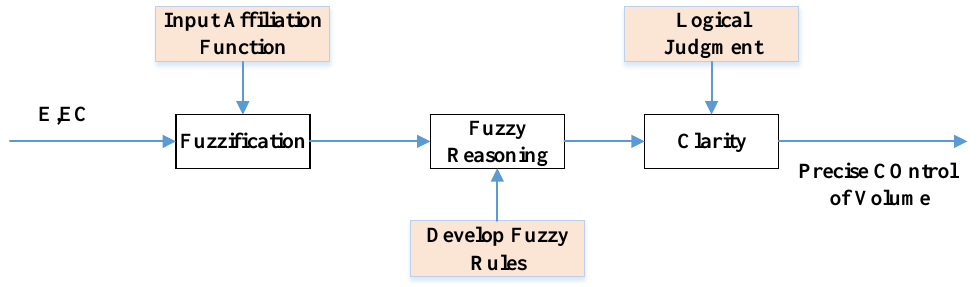
Figure 3. Design a fuzzy controller flow diagram. The adaptive fuzzy PID controller takes the difference between the target value of the wheel slip rate and the actual slip rate and the rate of change of the difference as the input of the controller, and adaptively adjusts the parameters K p , K i and K d of the incre- mental PID by the fuzzy inference method. Equation (32) is the adjustment formula, and the parameter adjustment process is shown in Figure 4.